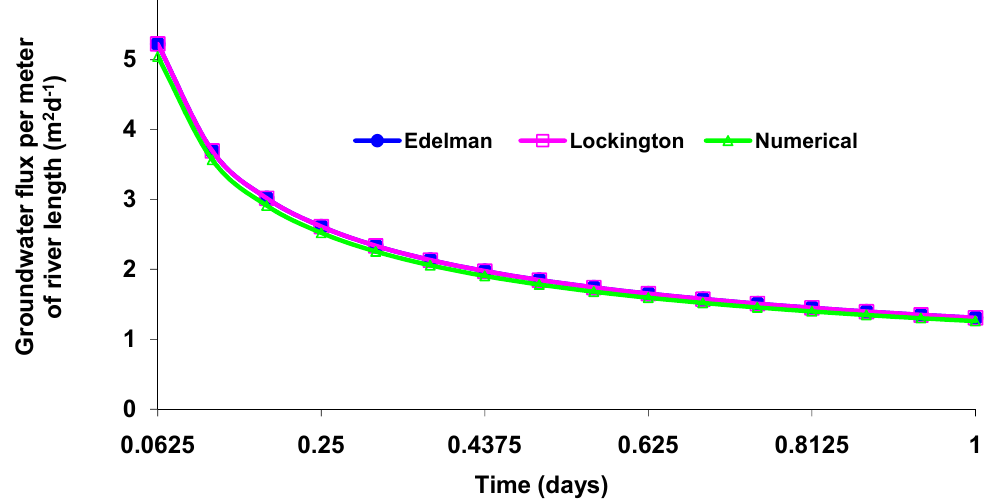
Figure 4. Groundwater discharge versus time at the river-aquifer boundary for numerical and analytical solutions (Edelman [31] and Lockington [32]) for a semi-infinite unconfined aquifer.